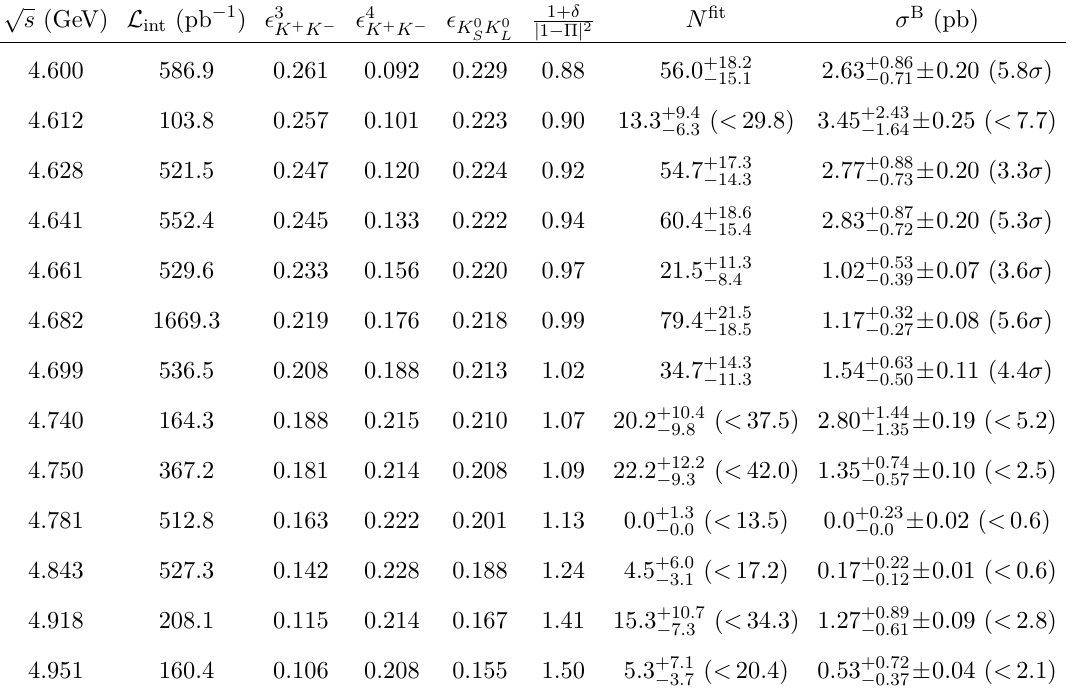
√ Table 1 . The Born cross section σ B for e + e − → φχ c 1 at each c.m. energy ( s ). The numbers in the brackets are the signal significances or upper limits σ U . L . at the 90% C.L. in case the signal significance is less than 3 σ . The table also includes integrated luminosity L int , detection efficiency (cid:15) 3 , (cid:15) 4 and (cid:15) for the 3-track events of the φ → K + K − mode, 4-track events of the K 0 K 0 K + K − K + K − S L φ → K + K − mode and the events of the φ → K 0 mode, respectively, the product of radiative K 0 S L correction factor and vacuum polarization factor 1+ δ and the number of fitted events N fit (also | 1 − Π | 2 the corresponding upper limit N U . L . at the 90% C.L. in case the signal significance is less than 3 σ